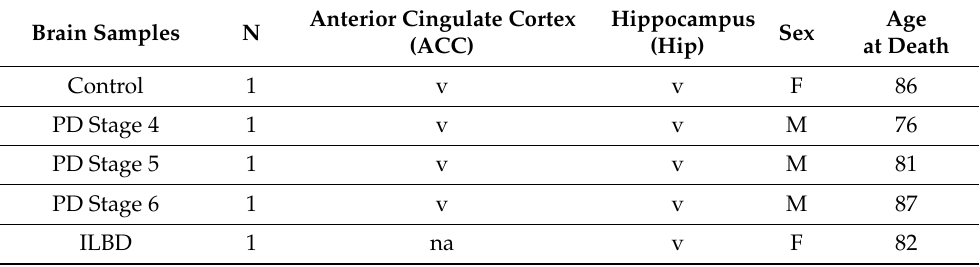
Table 2. Summary of post-mortem PD and ILBD brain tissue, alongside age matched control, used in the current pilot study; na is indicated for ILBD as only hippocampus was assessed.